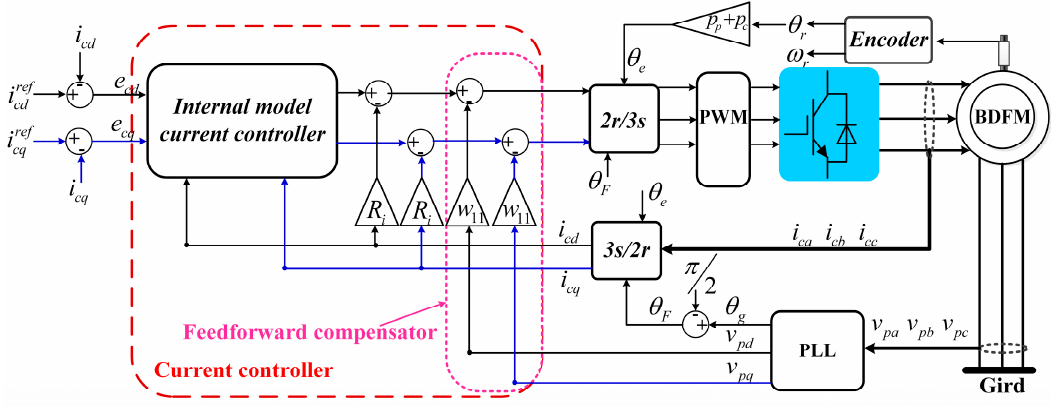
Figure 3. Schematic diagram for the CW current control of the brushless doubly-fed induction machine drive system.